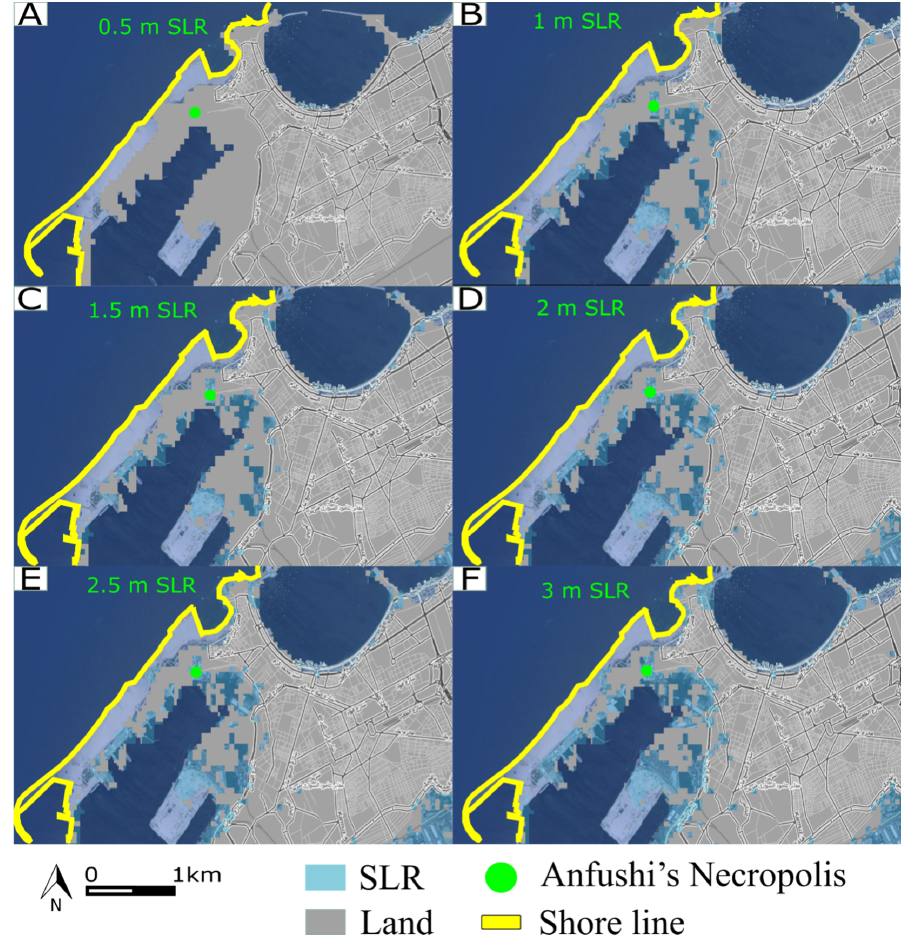
Figure 15. ( A – F ) Various scenarios for SLR influence on Anfushi’s